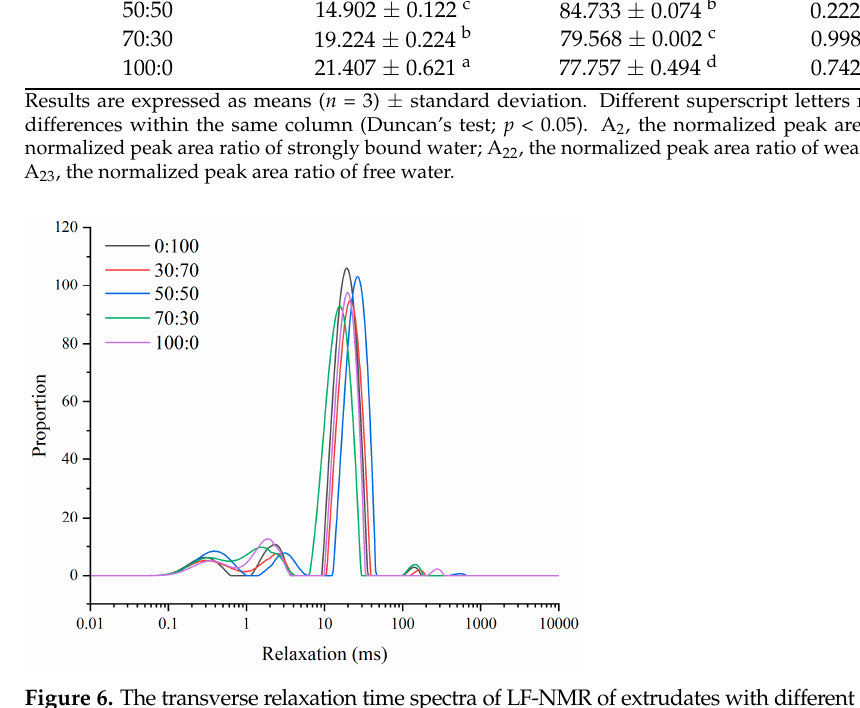
Figure 6. The transverse relaxation time spectra of LF-NMR of extrudates with different mixing ratios.